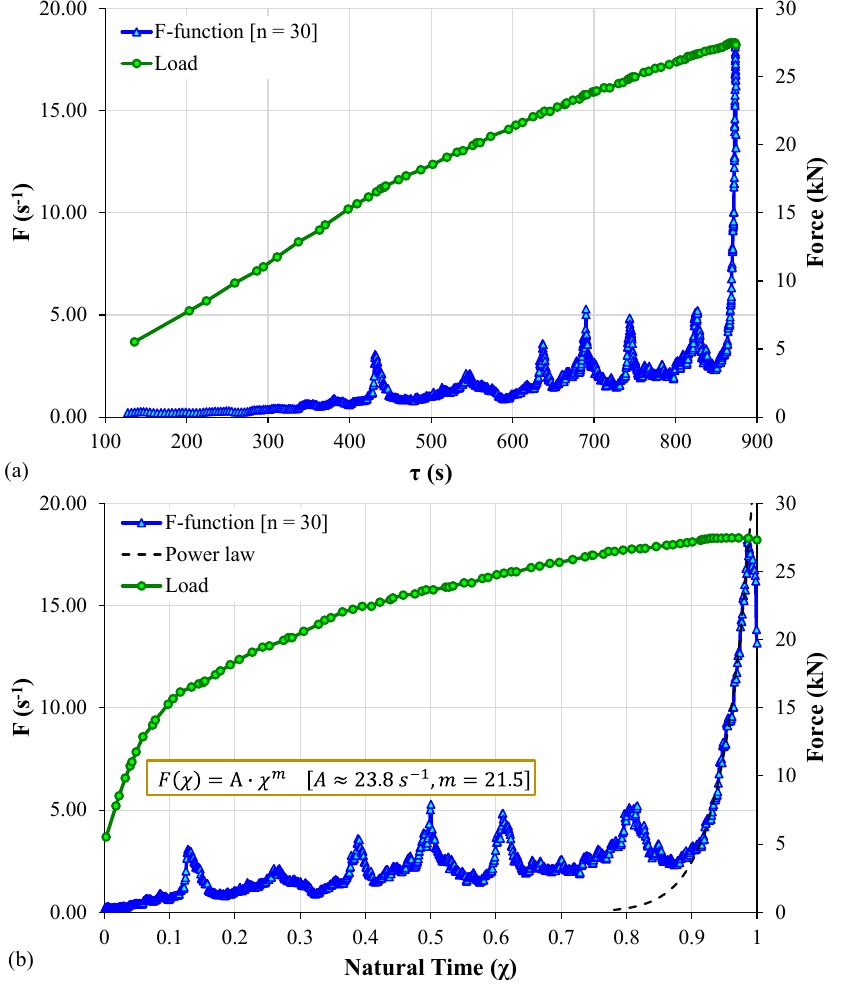
Figure 12. ( a ) The temporal evolution of the F -function and the load imposed. ( b ) The respective evolution in the Natural Time domain for the mutually interconnected marble blocks under shear.